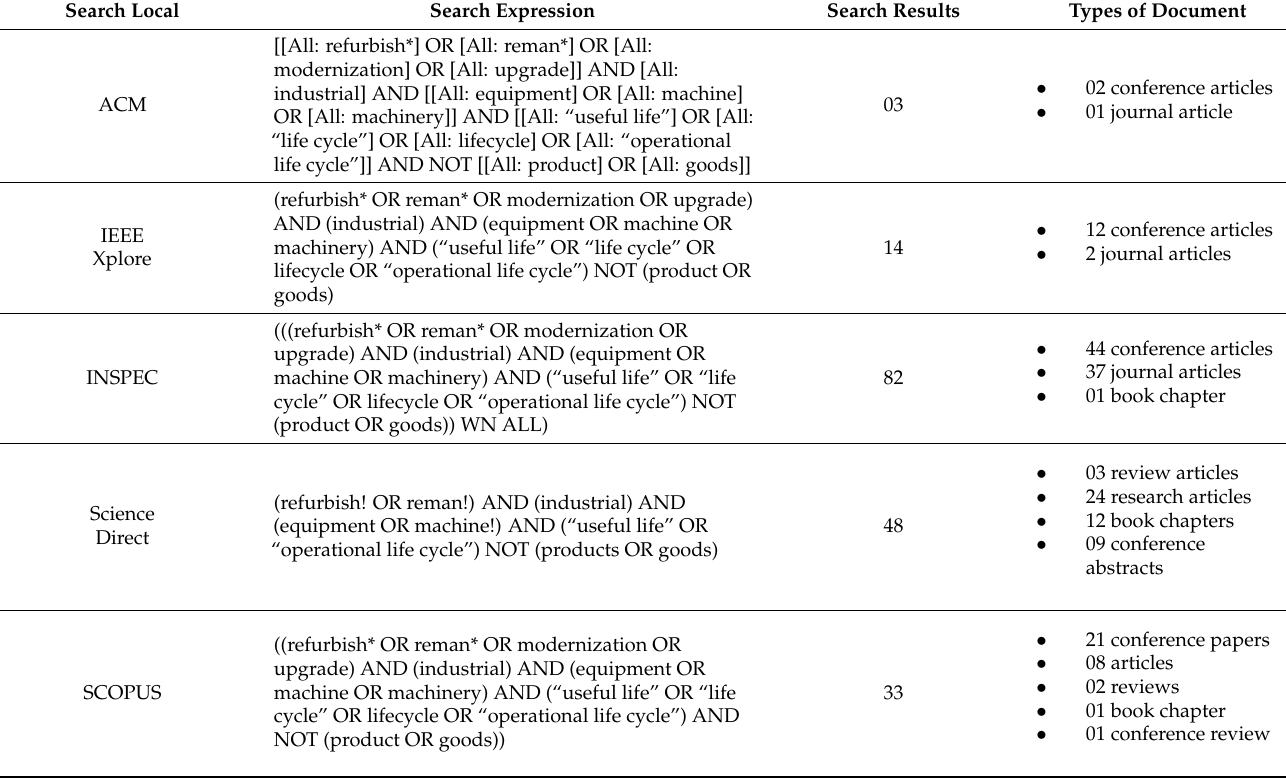
Table 1. Identification step